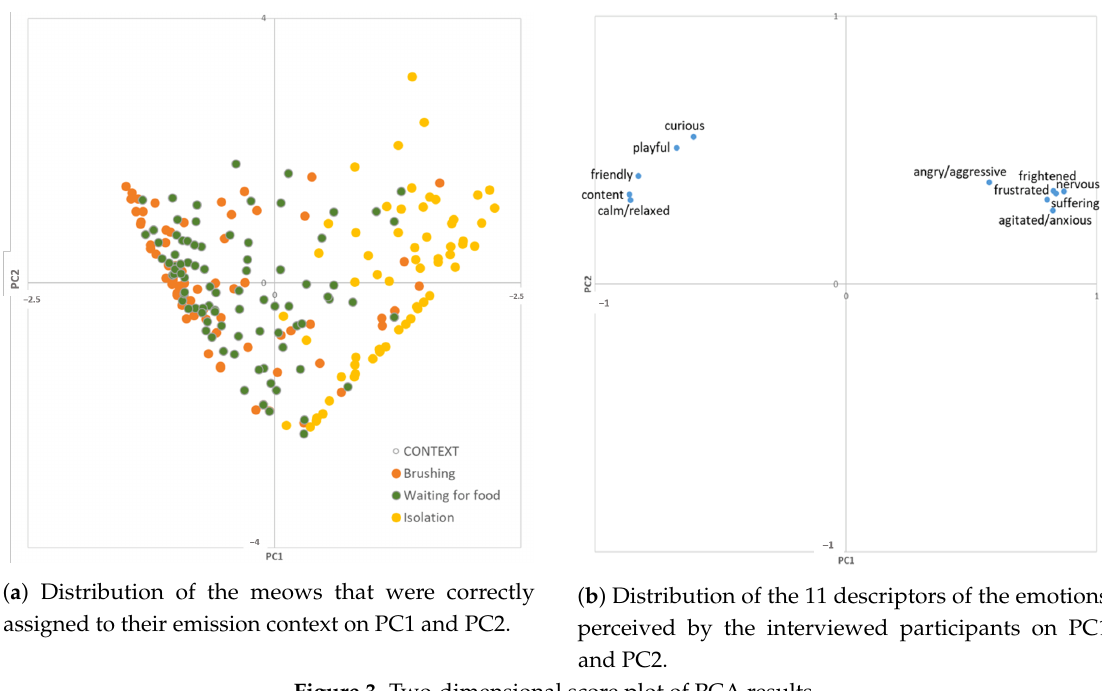
Figure 3. Two-dimensional score plot of PCA